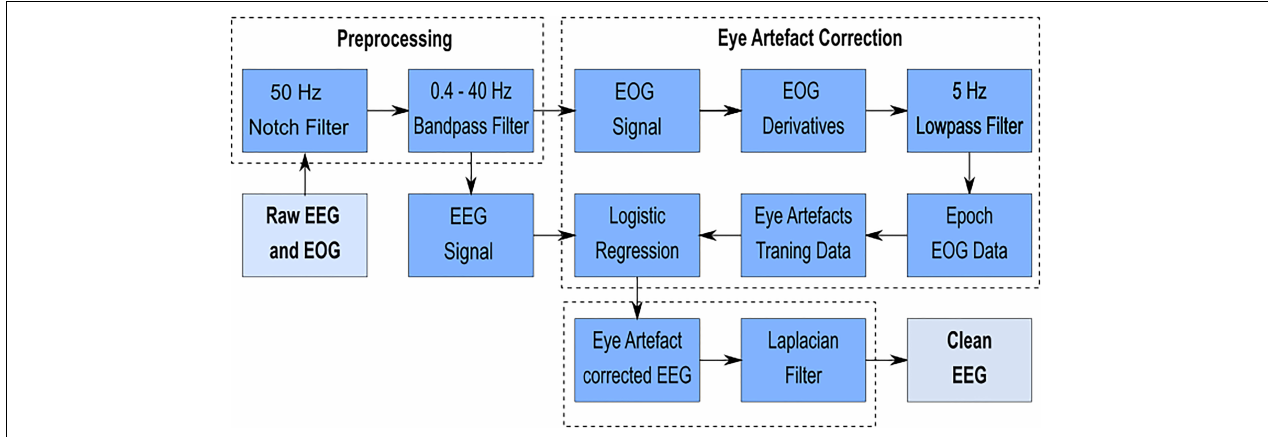
FIGURE 3 | Signal processing chain – The individual steps from the raw EEG and EOG signal to the clean EEG signal can be divided into three blocks: preprocessing, eye artifact correction [adapted from Kobler et al. (2017)] and spatial resolution